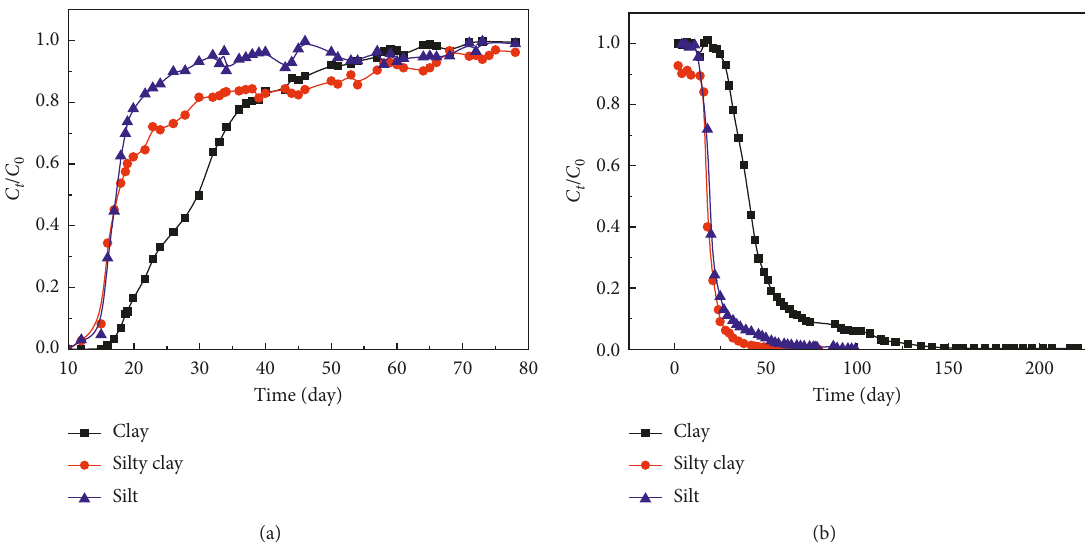
Figure 4: Breakthrough curves of adsorption columns (a) and desorption columns